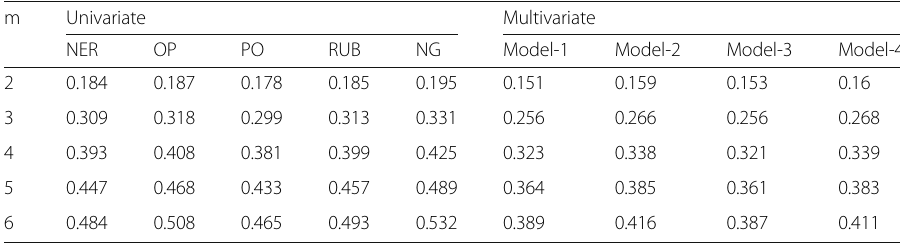
Table 3 BDS test statistics